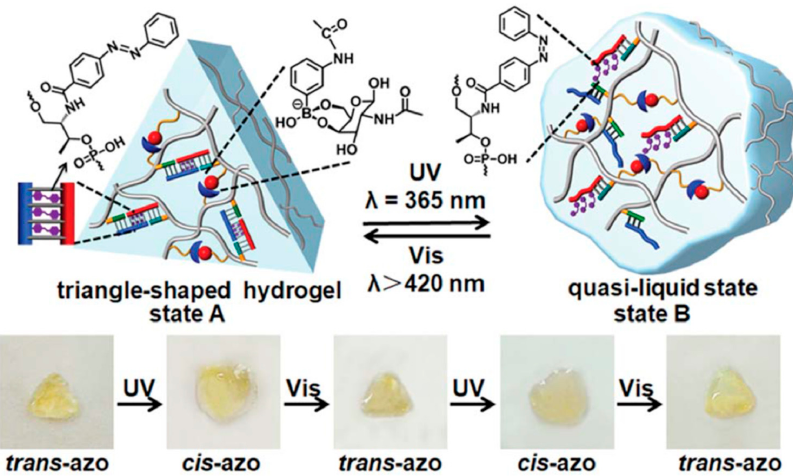
Figure 9. Schematic light-induced shape-memory transitions between the triangle-shaped, high-stiffness polyacrylamide-based hydrogel crosslinked by glucosamine–boronate ester bridges and trans-azobenzene stabilized duplex crosslinkers and the low-stiffness hydrogel crosslinked by the glucosamine–boronate esters only. Adapted from [435] Open Access, Copyright 2020, Royal Society of Chemistry].